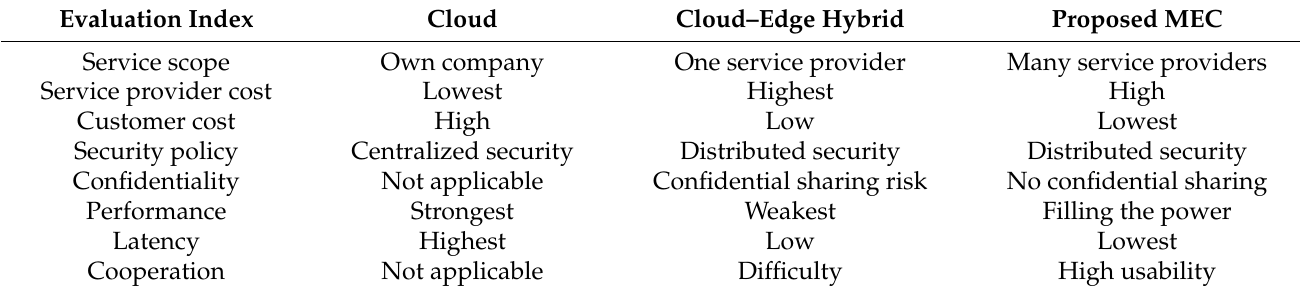
Table 3. Qualitative comparison in terms of the service provision of the existing and proposed structures. Evaluation